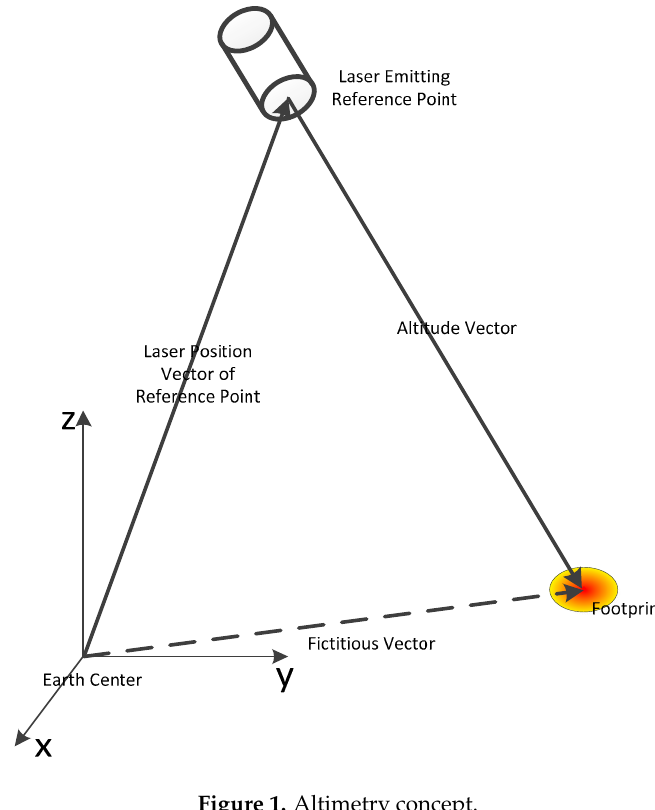
Figure 1. Altimetry concept.